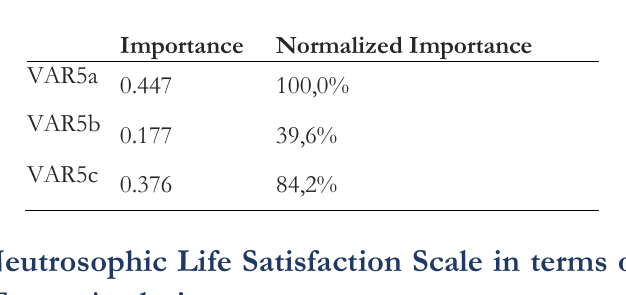
Table 11. Correlation among neutrosophic item 5 and classical item